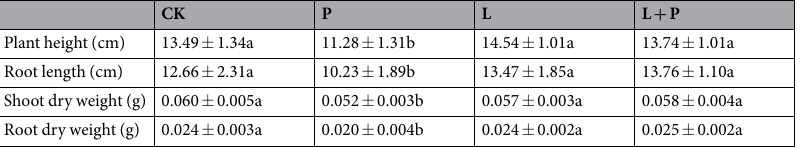
Table 1. Effect of He-Ne laser pretreatment on root length, plant height, shoot dry weight, and root dry weight of the 7-day-old wheat seedlings treated with natural drought stress without water for 5 days. Different treatment represents: The control (CK), natural drought stress (P), 3 min laser radiation (L), 3 min laser radiation + natural drought stress (L + P). Data are means of 30 seedlings, and each mean in a line followed by a different letter indicates that there are significant differences at 0.05 level according to Duncan’s multiple range